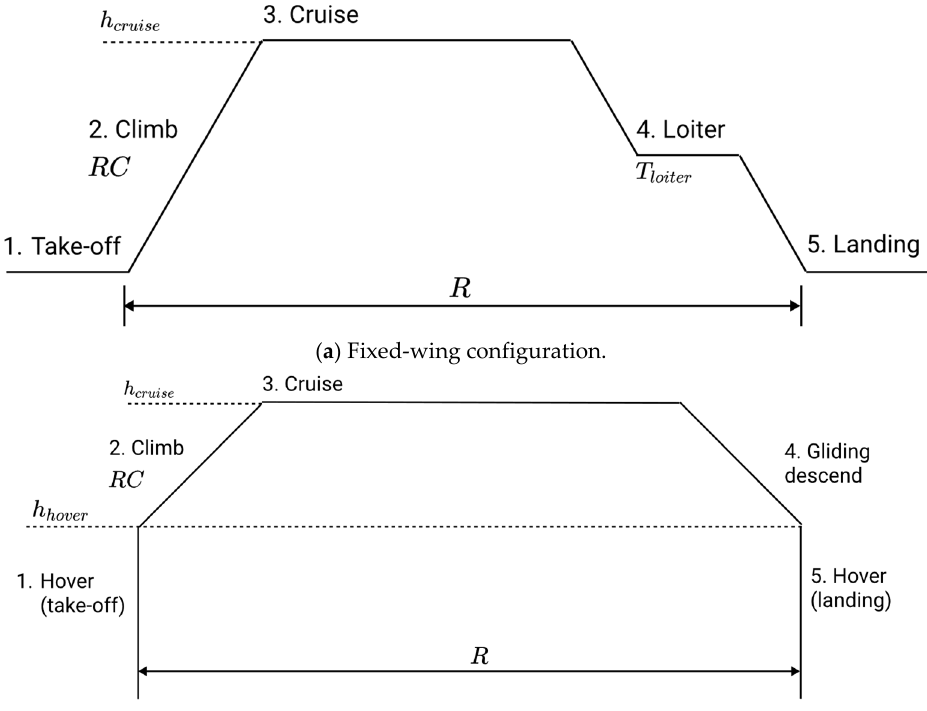
Figure 12. Generic mission profiles.